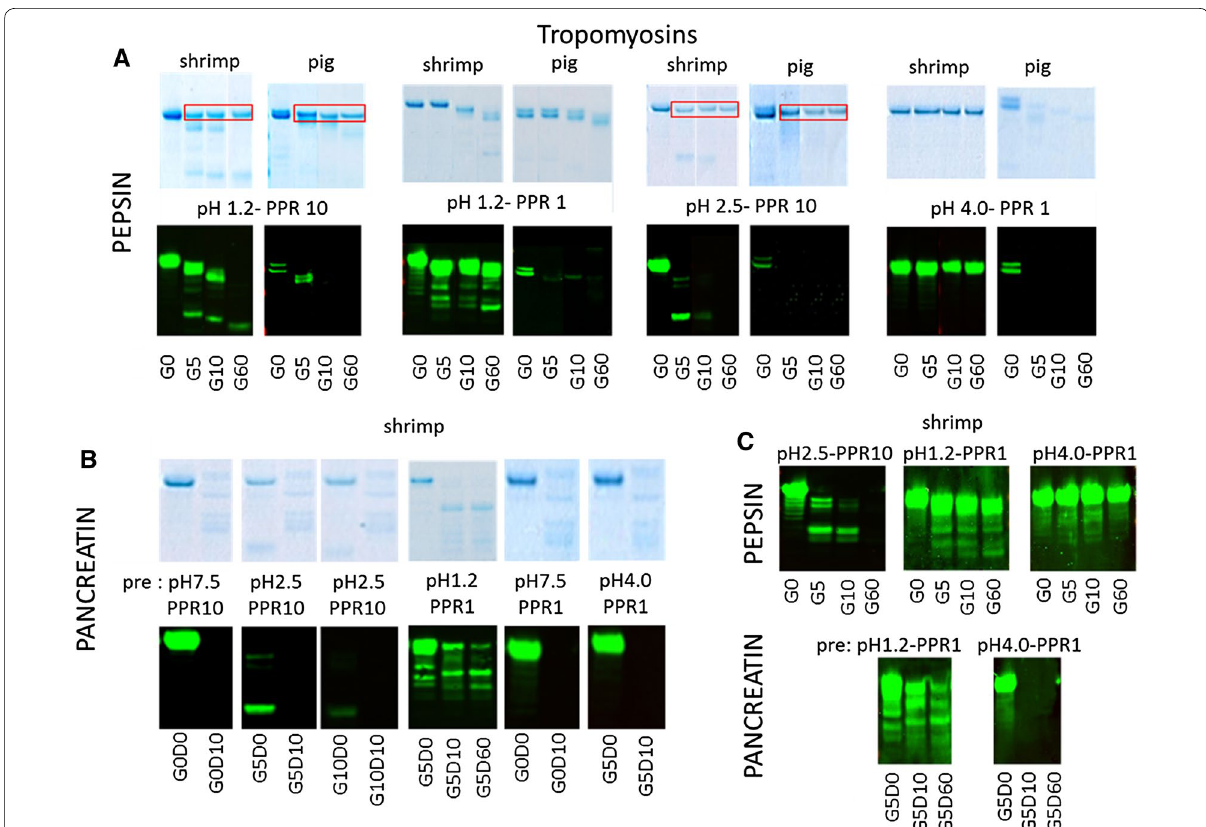
Fig. 4 Selected SDS‑PAGE and immunoblot samples are shown for both tropomyosins, from shrimp (Pen a 1) and pig. A At pH 1.2 and 2.5 judged by SDS‑PAGE no very clear difference in resistance is apparent, although for shrimp tropomyosin the presence of breakdown peptides at PPR 10 appears to be more prominent. Pepsin bands visible at PPR 10 are boxed in red. At PPR 1 resistance of both tropomyosins appears quite high. Immunoblot analyses of gastric samples exposed to pH 1.2 and 2.5 confirm higher stability of shrimp tropomyosin but it cannot be excluded that this is rather a result of different affinities of rabbit antisera. The most convincing difference between allergen and non‑allergen is observed at pH 4.0, with shrimp tropomyosin being totally unaffected and pig being readily digested. B Shrimp tropomyosin is highly susceptible to pancreatin except when having been pre‑exposed to pH 1.2. C IgE immunoblotting confirms pepsin and pancreatin resistance characteristics observed